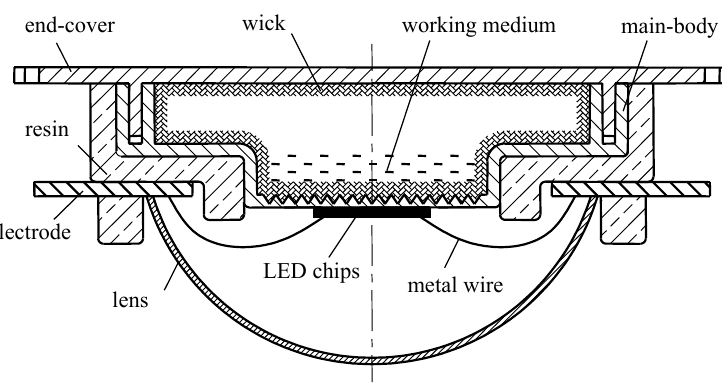
Figure 1. The schematic to the packaging of high-power LED with phase-change heat sink.